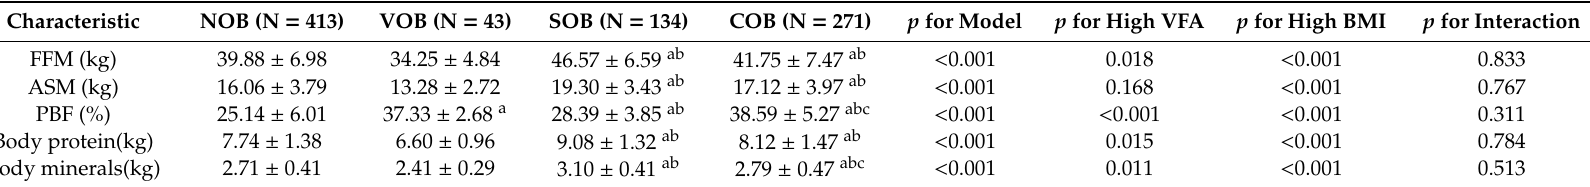
Table 4. Associations among high BMI, high VFA, and body